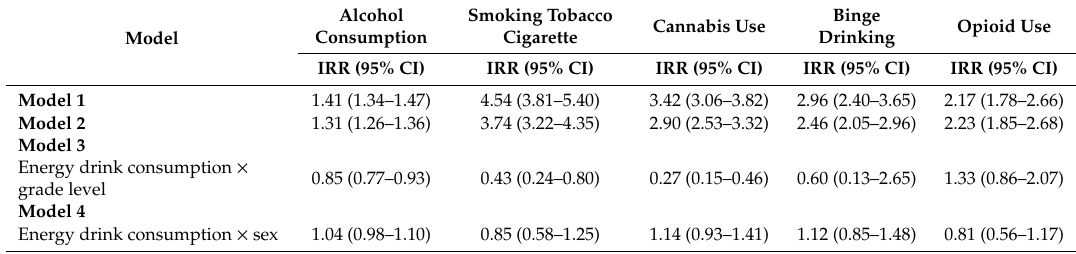
Table 3. Crude and adjusted Poisson regression models for the associations between energy drink consumption in the past 12 months and substance use outcomes among adolescents, OSDUHS, 2017 ( n =